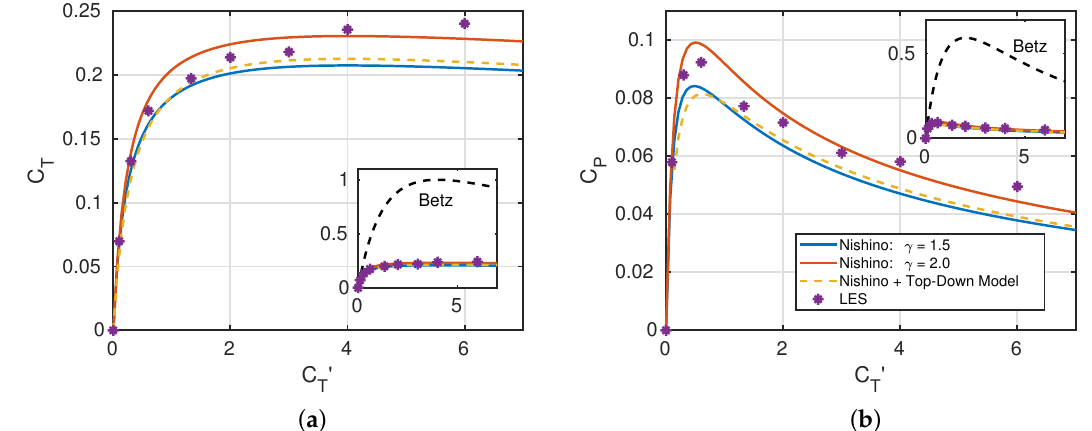
Figure 17. ( a ): C T computed directly from LES data, with predictions from Nishino’s model. ( b ): C P computed directly from LES data, with predictions from Nishino’s model. The Betz prediction for an isolated turbine is shown in the